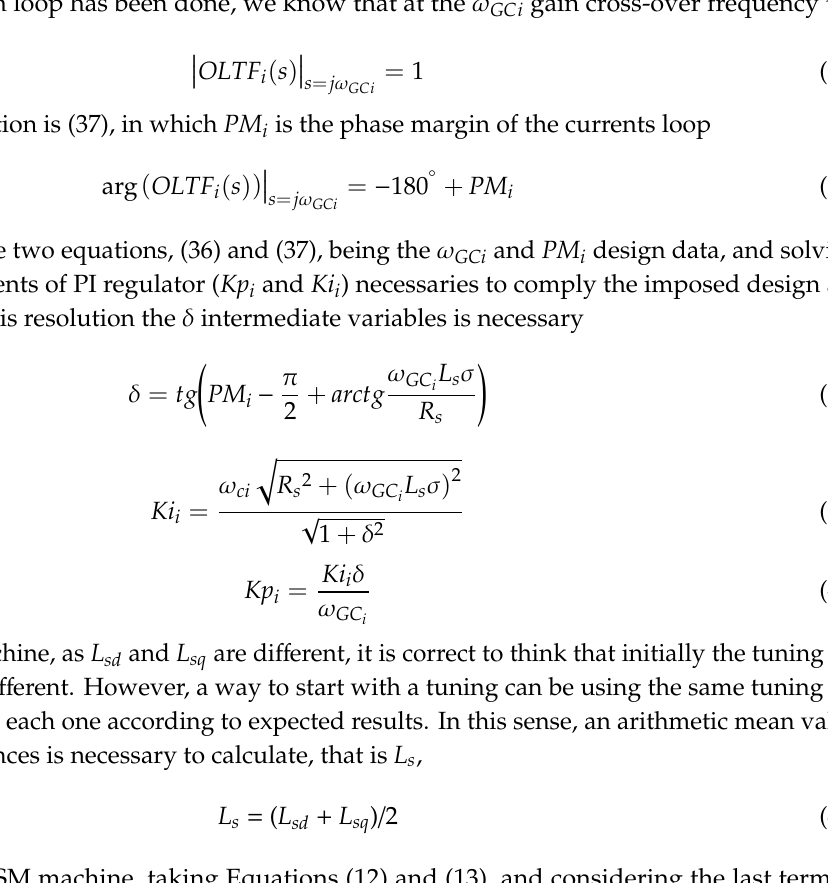
Figure 4. Simplified scheme of the PI regulator for i sq and i sd currents loops (induction motor (IM) machine case).